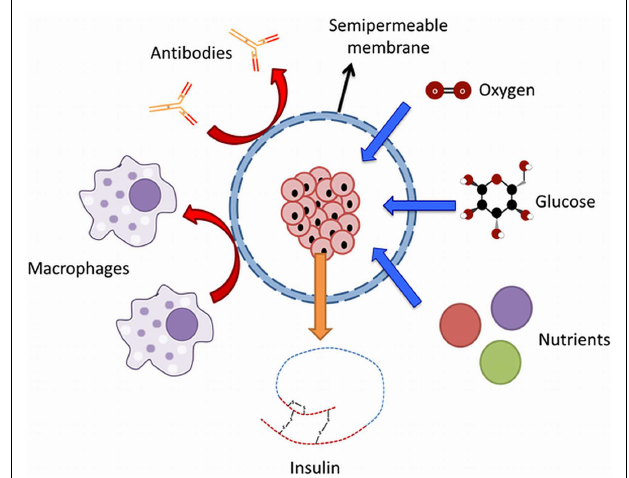
FIGURE 1 |The three different categories of encapsulation devices used for immunoisolation of islets . Comparison between size and diffusion rate of nutrients and oxygen through the semipermeable membranes.